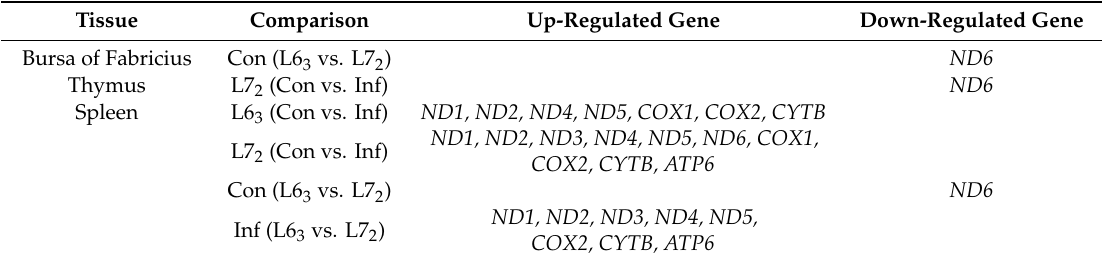
Table 1. Differentially expressed mitochondrial DNA genes in three lymphoid organs.